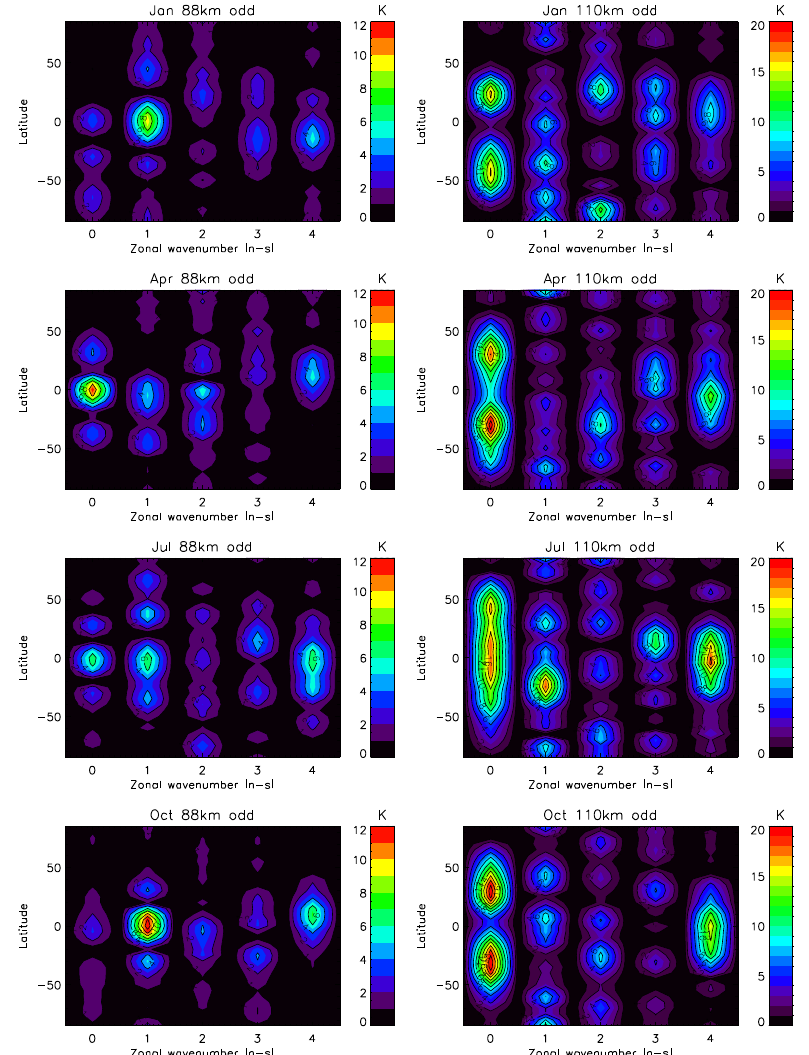
Figure 2. MIPAS (cid:49)T/ 2 average (2007–2012) monthly mean spectra at 88km (left) and 110km (right) for January (first row), April (second row), July (third row) and October (fourth row). MIPAS zonal wavenumbers correspond to | n odd − s | of the daily frequency n and the zonal wavenumber s of comprised tidal modes (see Table